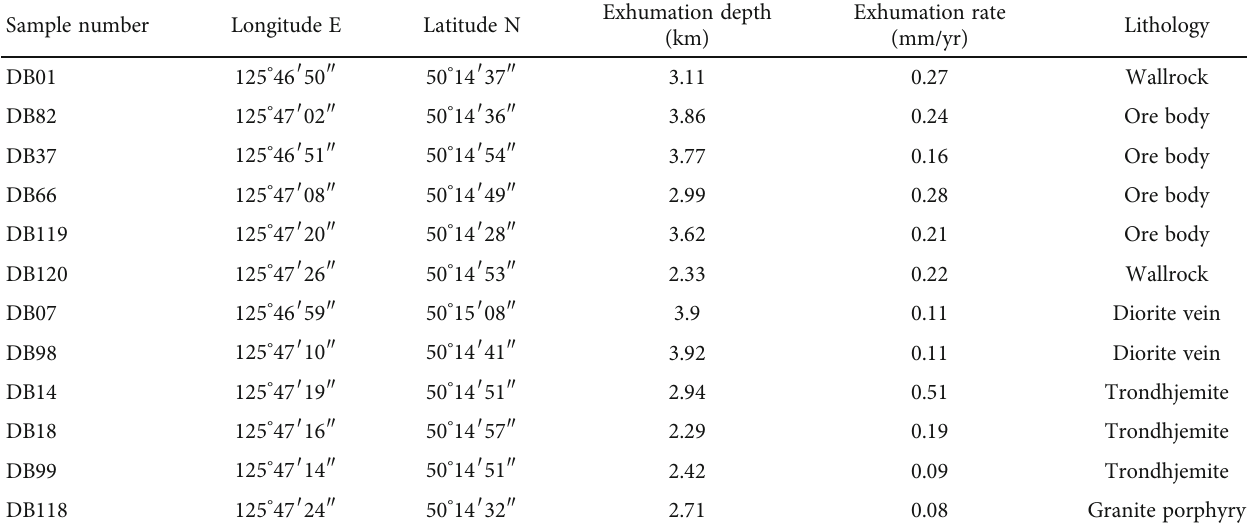
Table 3: Sample locations and exhumation depth of the Duobaoshan rock body.